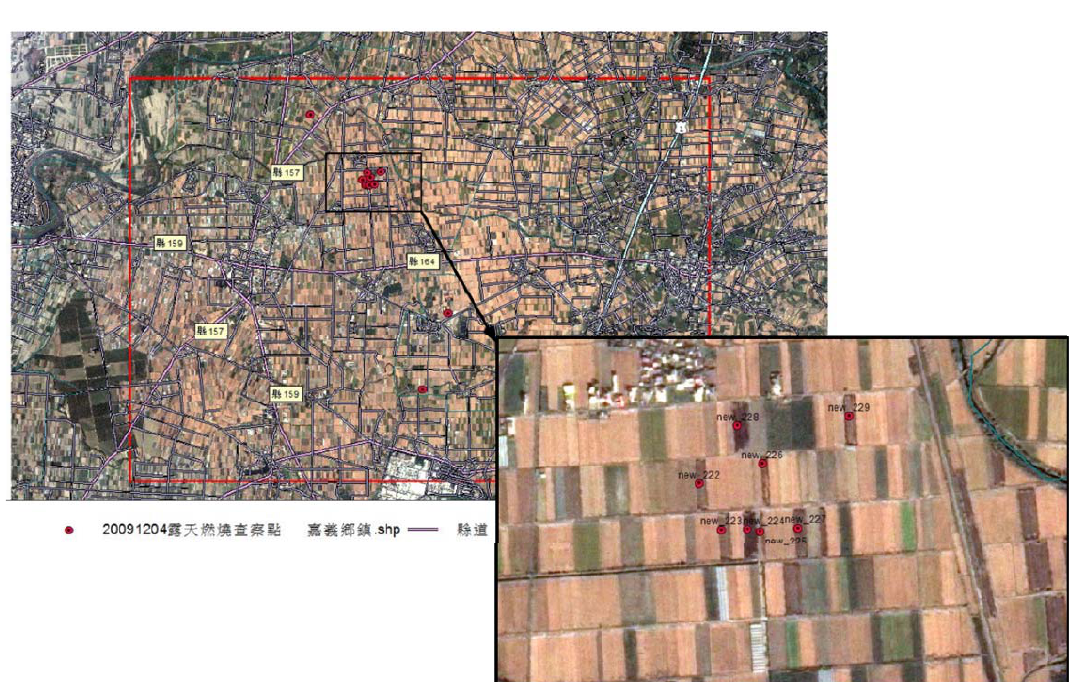
Fig.5 Study area (Xikou Township)